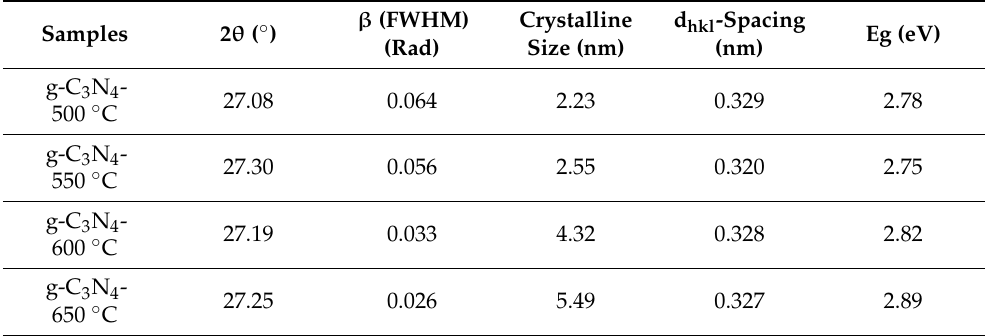
Table 1. Summary of structural properties and bandgap energy (eV) of all prepared g-C 3 N 4